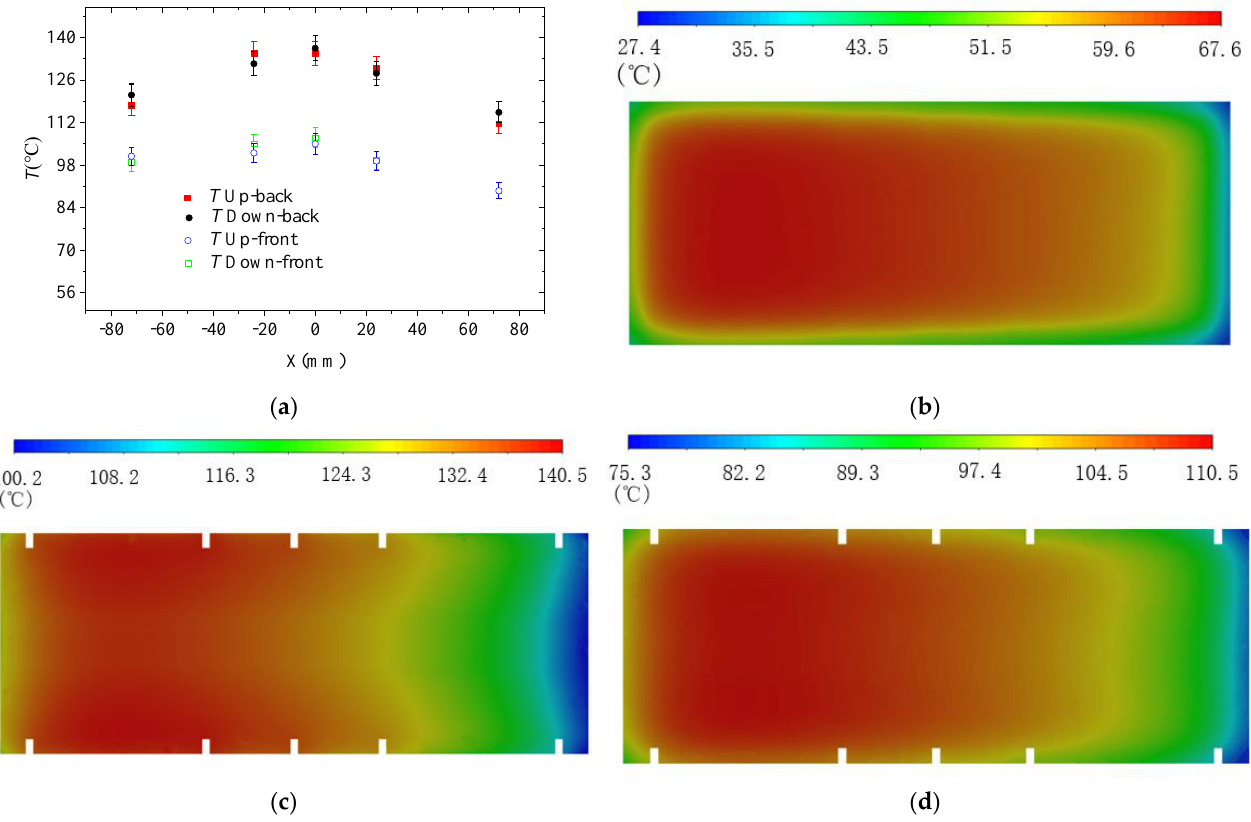
Figure 7. Temperature distribution: ( a ) average temperature of measuring points and heat transfer wall temperature under different flow rates; ( b ) temperature distribution of heat transfer surface; ( c ) temperature distribution of heater section in back row thermometer position; ( d ) temperature distribution of heater section in front row thermometer position.